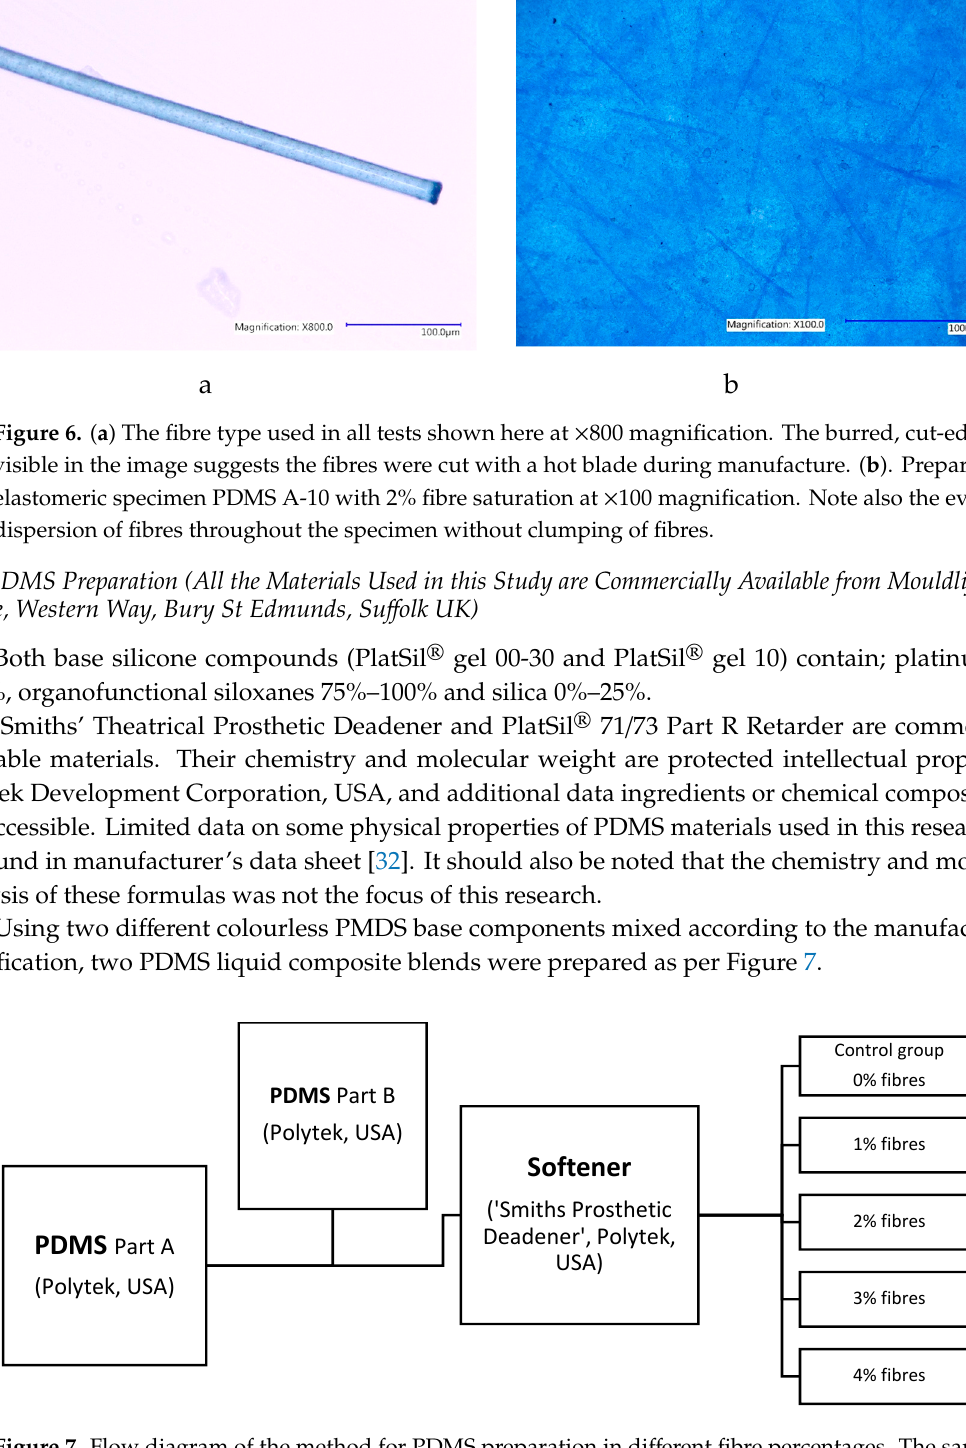
Figure 7. Flow diagram of the method for PDMS preparation in di ff erent fibre percentages. The same method (but di ff erent ratios) was used in all material sheet preparations. The ratios for each are given in Supplementary File